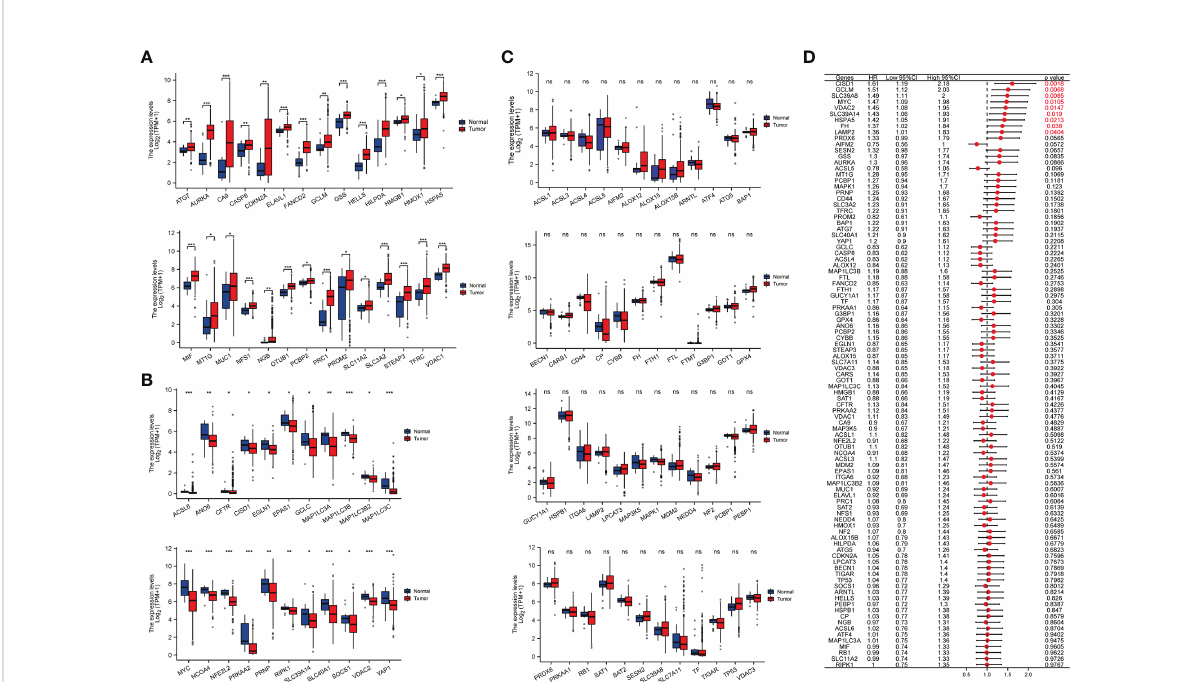
FIGURE 1 The relative expression levels and prognostic values of ferroptosis regulators in TCGA-BLCA cohort. (A) 28 signi fi cantly upregulated ferroptosis regulators in BCa. (B) 22 signi fi cantly downregulated ferroptosis regulators in BCa. (C) The expression levels of 48 ferroptosis regulators were not signi fi cantly different between BCa and normal bladder tissues. (D) The prognostic values of ferroptosis regulators in BCa, the red font represents statistical signi fi cance. *p < 0.05; **p < 0.01, ***p < 0.001. NS, Non Signi fi